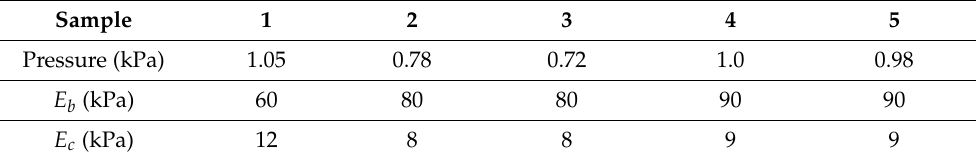
Table 2. Inlet pressure in the experiments and Young’s modulus for the vocal fold body, E b , and for the vocal fold cover, E c , which were previously determined for each individual samples (Data from [27]).